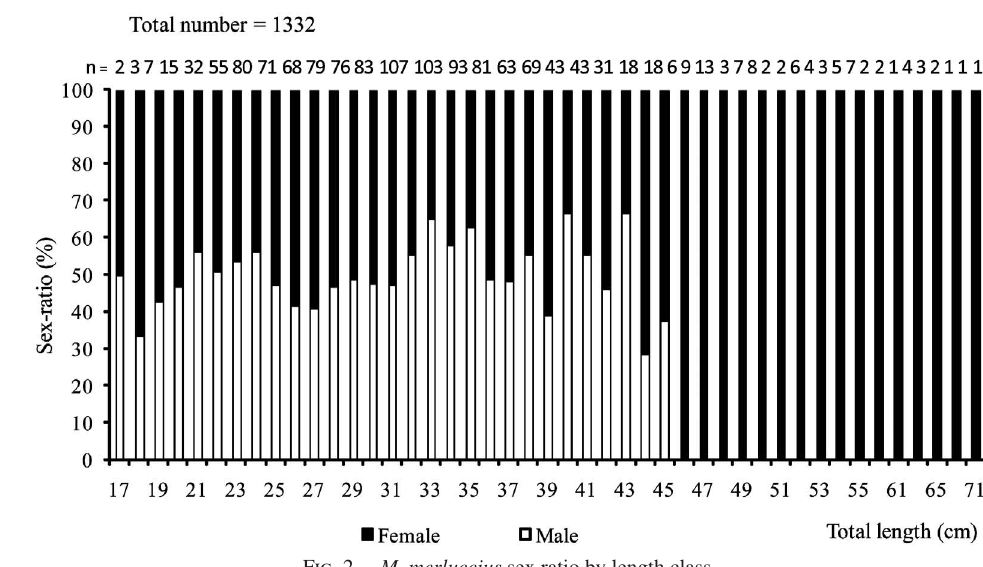
Fig . 2. – M. merluccius sex ratio by length class. Table 3. – Sex ratio of M. merluccius by length interval, tested with an c 2 analysis at P = 0.05% Length interval Number of individuals Males Females